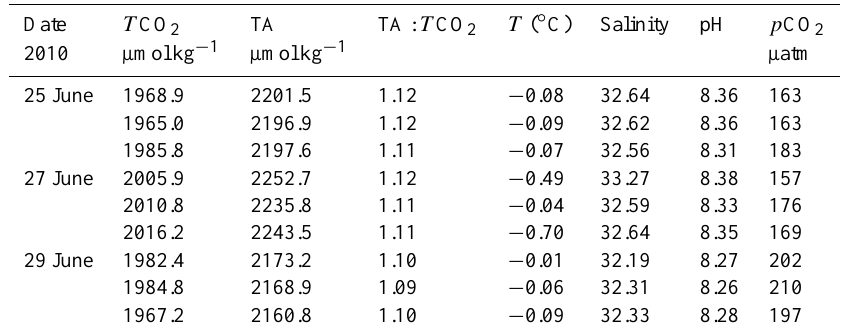
Table 1. Surface water conditions (20cm below sea ice) of temperature, salinity, T CO 2 , TA and p CO 2 during the field campaign. Data from triplicate samples collected on three separate occasions are shown.